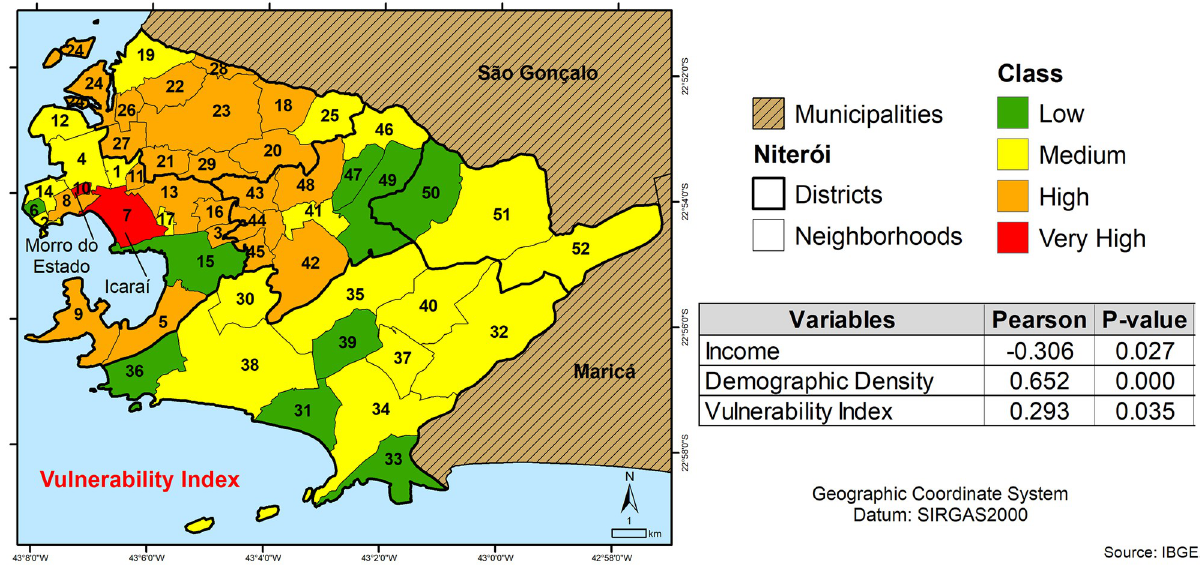
Fig 6. Vulnerability index map, showing the distribution of neighborhoods in the municipality of Nitero´i. In red are highlighted the neighborhoods of Icaraı´(7) and Morro do Estado (10) (https://www.ibge.gov.br/en/geosciences/downloads-geosciences.html).